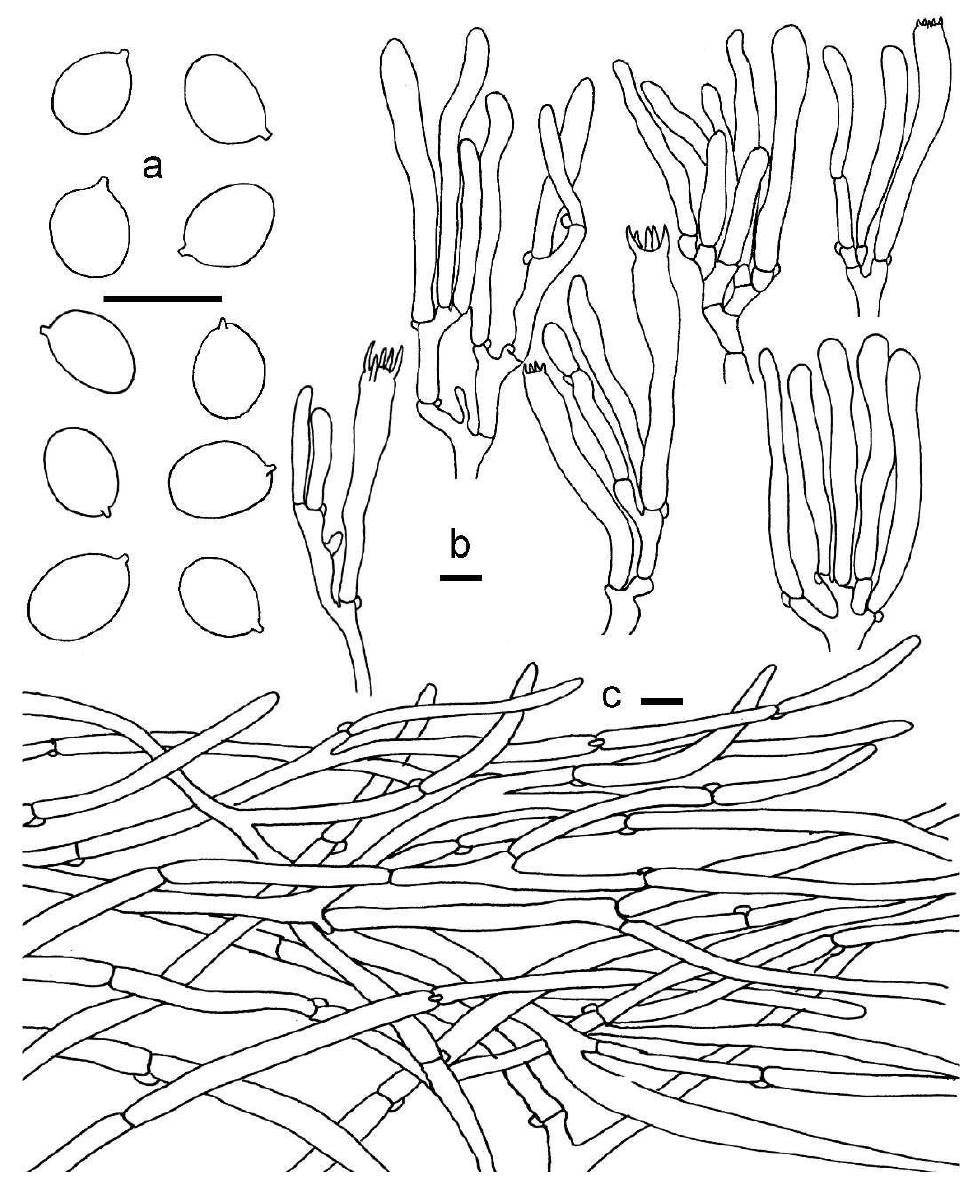
Figure 11. Cantharellus phloginus . ( a ) Basidiospores. ( b ) Basidia, basidiola and elements of the subhymenium. ( c ) Pileipellis. Bars: ( a , b ) = 10 μ m; ( c ) = 20 μ m.